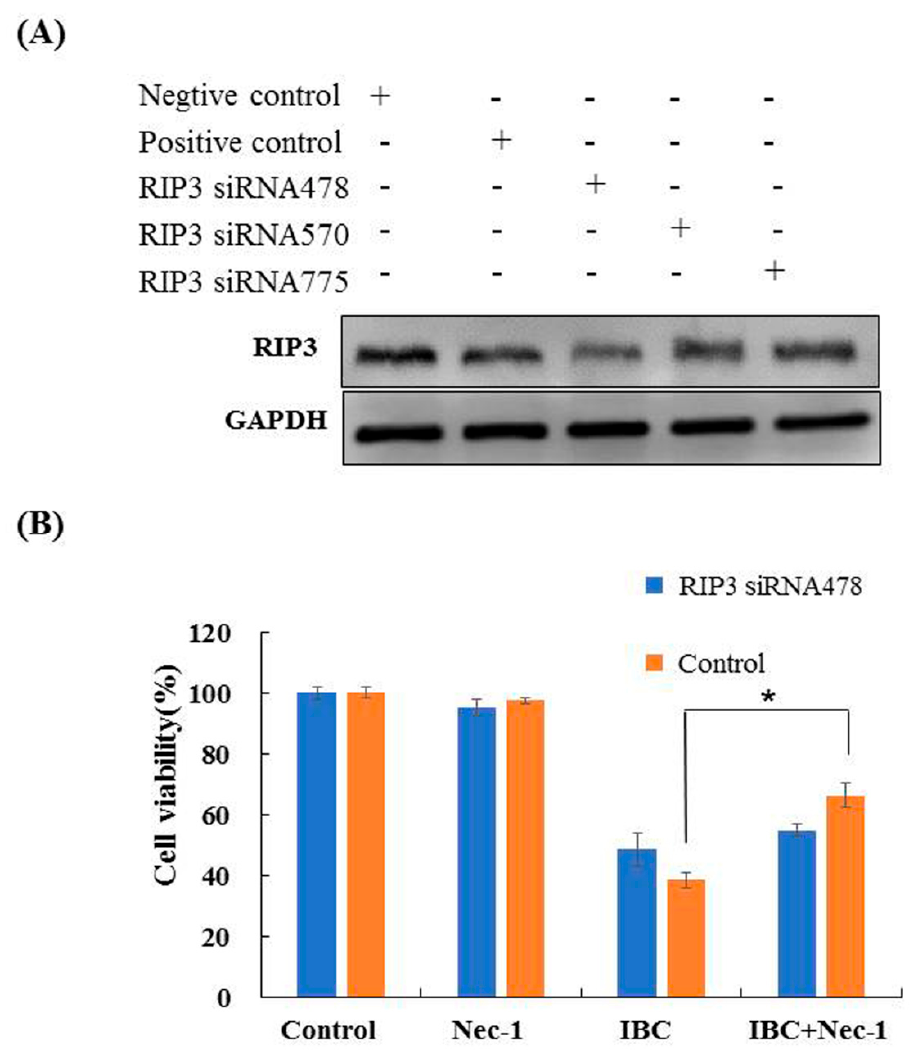
Figure 7. Knock-down of RIP3 with siRNA protected against IBC-induced necroptosis in MDA-MB-231 cells. ( A ) The cells were transfected with RIP3 siRNA, and whole cell lysates were subjected to Western blotting analysis. ( B ) After transfection with RIP3 siRNA, the cells were treated with IBC (40 µM) for 24 h, without or with pre-treatment with Nec-1. The cell viability was detected using the MTT assay. * p < 0.05 compared between the groups of IBC and IBC with Nec-1.